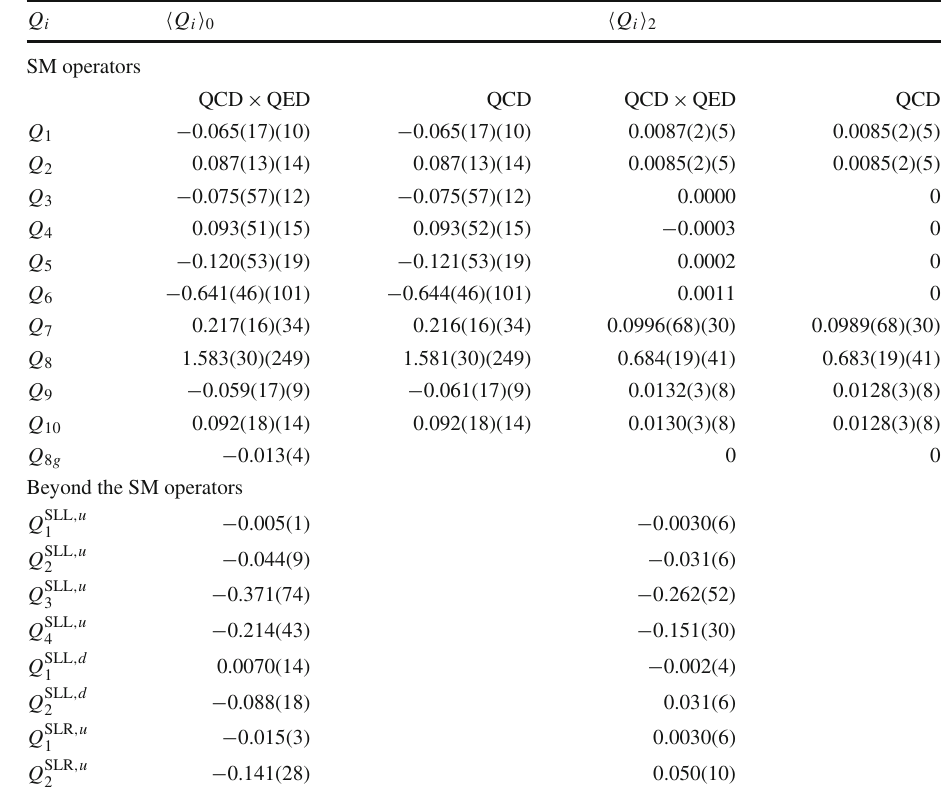
Table 5 Numerical values of K → ππ hadronic matrix elements from the literature in units of GeV 3 in the MS scheme at the scale μ = 1 . 3GeV, with statistical and systematic uncertainties. For the SM four-quark operators we provide the values obtained by RG equations with NLO QCD × QED and only NLO QCD. The normalization convention is chosen to be h = 1 for all operators.